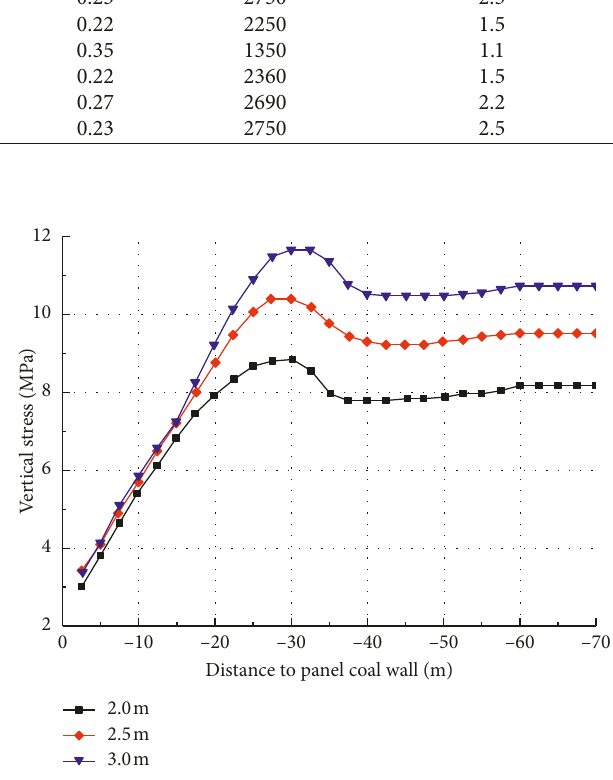
Figure 10: Relations between vertical stress of the filling body and distance to the panel coal wall.